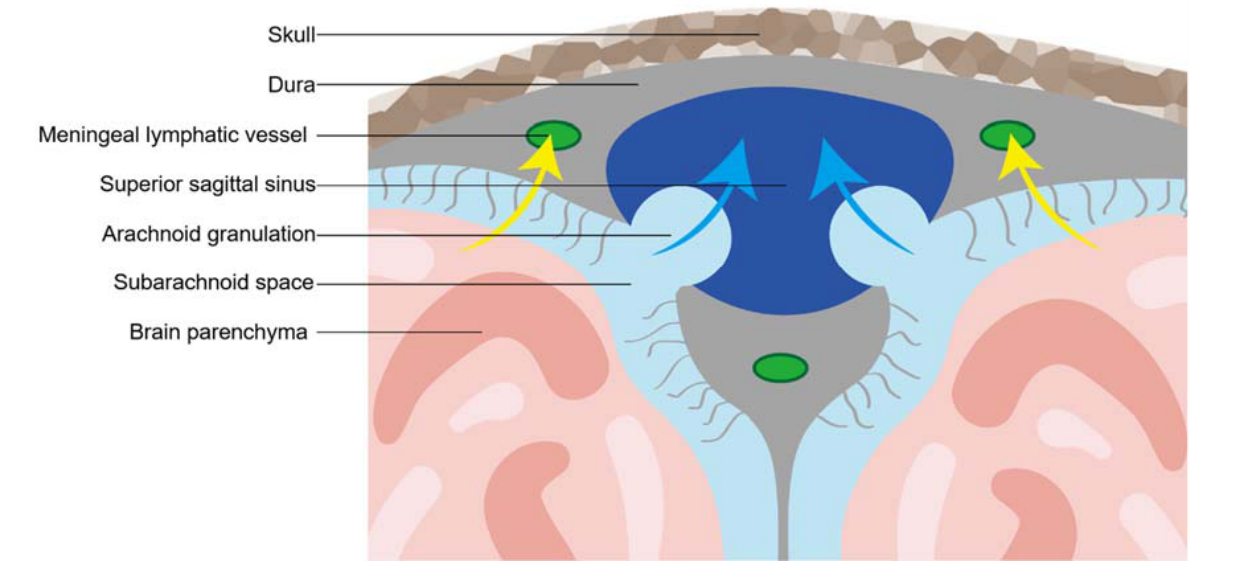
Figure 3. A brief overview of meningeal lymphatic vessels. Meningeal lymphatic vessels (mLVs) could be described as a lymphatic network in the central nervous system that expresses classic protein markers of lymphatic endothelial cells, such as lymphatic vessel endothelial hyaluronan receptor 1 (LYVE1), vascular endothelial growth factor receptor 3 (VEGFR3), prospero homeobox protein 1 (Prox1), and chemokine (C-C motif) ligand 21 (CCL21). Developmentally, the maturity of mLVS depend on vascular endothelial growth factor C (VEGF-C). Anatomically, mLVs extend from the superior sagittal sinus and the transverse sinuses to into the deep cervical lymph nodes (dCLNs). Functionally, mLVs play a significant role in draining of CSF, metabolic waste, immune cells, or other substances.